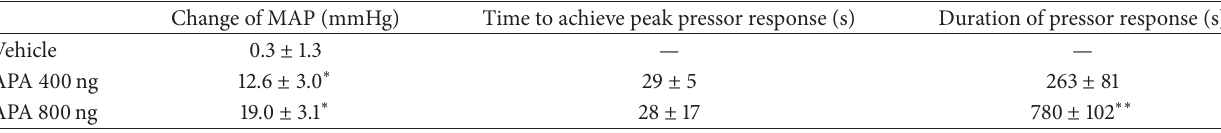
Table 1: Intracerebroventricular administration of aCSF, 400 ng of aminopeptidase A (APA), and 800 ng of APA. Change of MAP (mmHg) Time to achieve peak pressor response